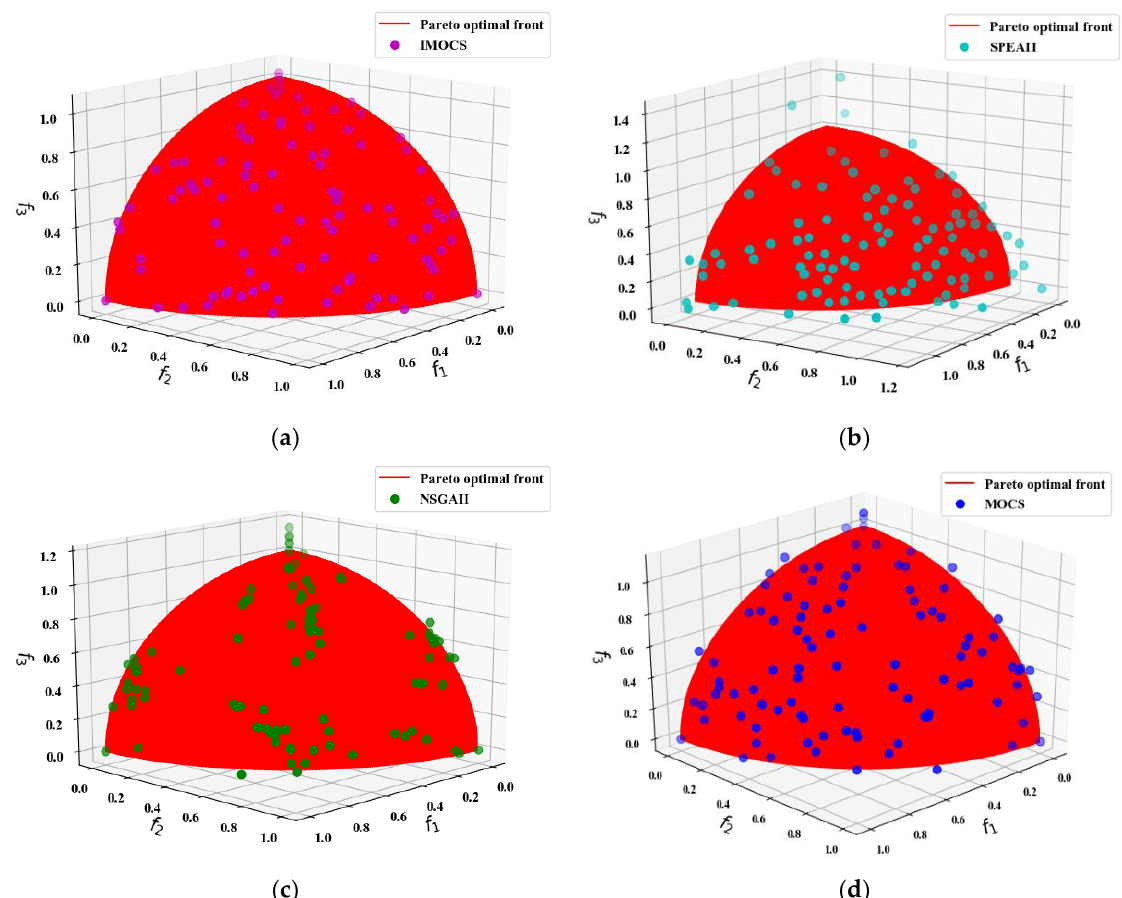
Figure 7. The convergence results of DTLZ2 test problem over all algorithms. ( a ) IMOCS, ( b ) SPEAII, ( c ) NSGAII, and ( d ) MOCS.